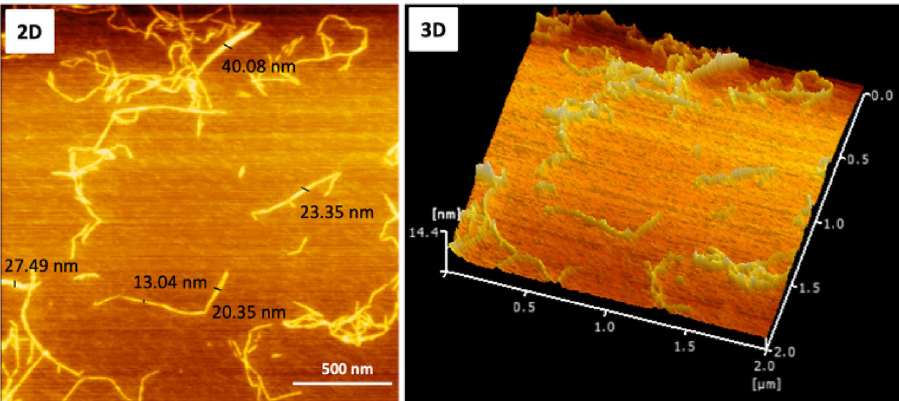
Figure 1. AFM images represent the morphology of two- and three-dimensional of